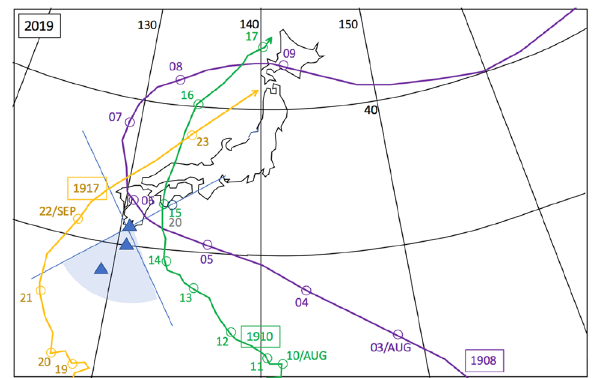
Figure 3. Meteorological history of tropical cyclons T-1908, T-1910, and T-1917 48 . This figure is drawn, same with Fig. 2. HKMT drew the map with Microsoft PowerPoint software and HKMT drew the image with Microsoft PowerPoint software and holds the copyright.